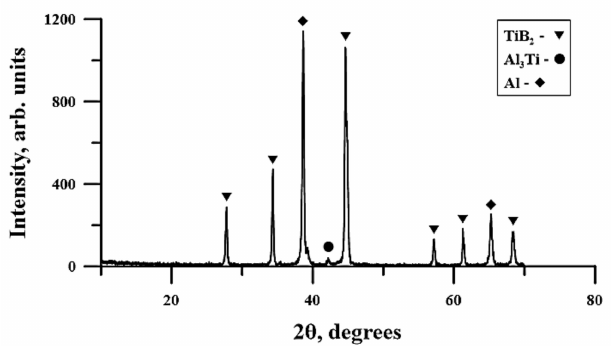
Figure 10. Typical X-ray diffraction (XRD) pattern of the planetary milled Al–Ti–B-based combustion product. Table 5. XRD-analysis results of synthesized products based on the planetary milled Al-Ti-B mixture. Specimens Phases Composition, wt.%